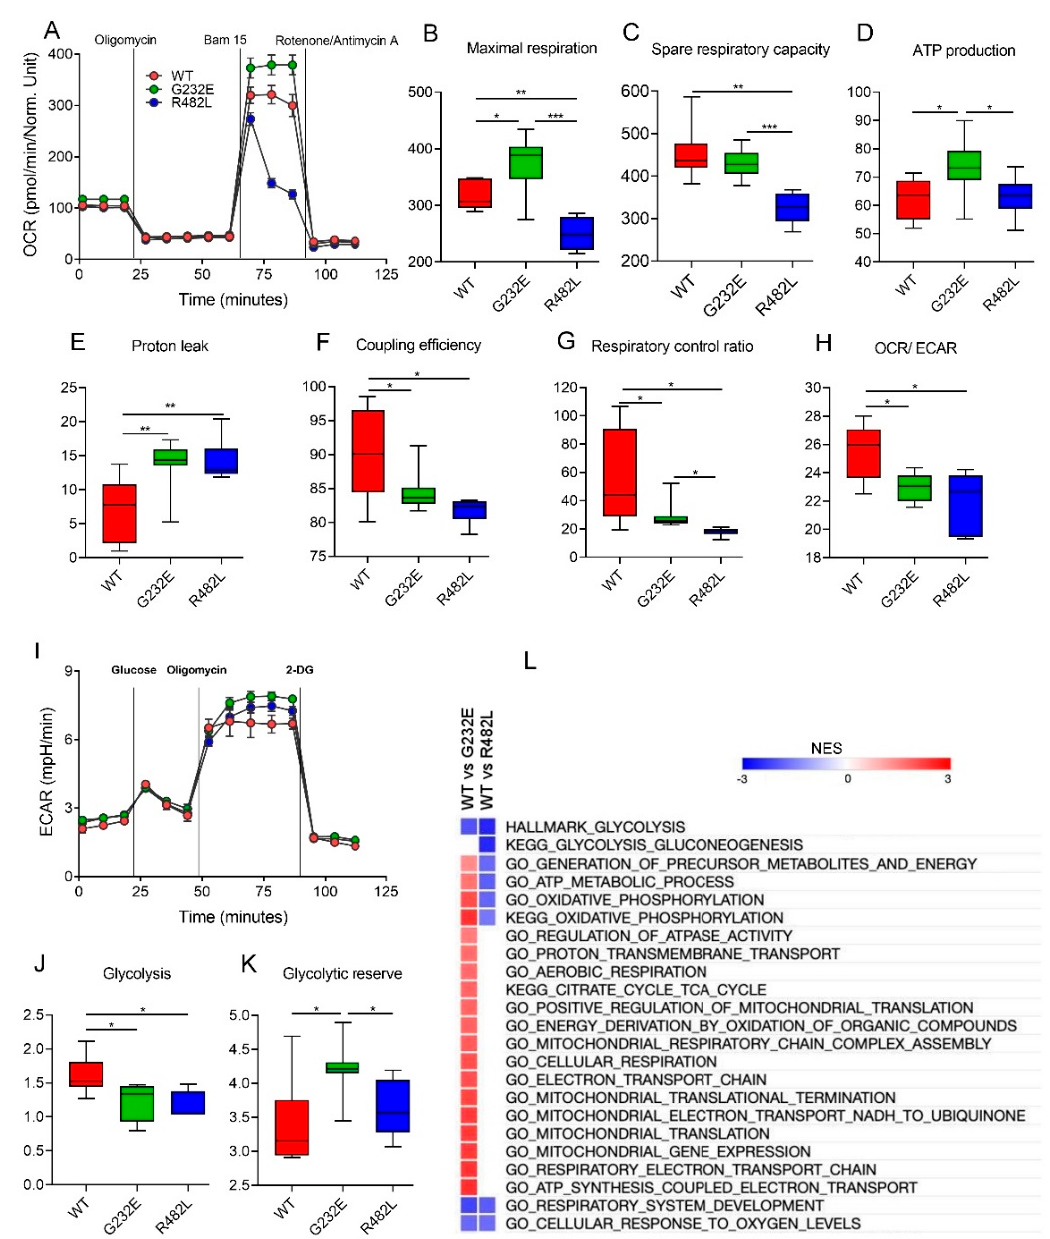
Figure 4. Metabolic profiles of C2C12 myotubes bearing lentiviral WT / G232E / R482L- LMNA . ( A – H ): Determination of mitochondrial bioenergetic parameters from OCR profile. ( A ) OCR traces for myotubes expressing WT / G232E / R482L- LMNA ; ( B – G ) Indices of mitochondrial respiratory function: ( B ) maximal respiratory capacity; ( C ) spare respiratory capacity; ( D ) ATP-linked respiration; ( E ) proton leak respiration; ( F ) coupling e ffi ciency; ( G ) cell respiratory control ratio; ( H ) OCR / ECAR ratio at maximal respiration. OCR was measured at the same time as ECAR. ( I – L ): Determination of glycolytic function. ( I ) Kinetic profiles of ECAR in myotubes expressing WT / G232E- LMNA / R482L- LMNA . ECAR was measured in real time, as indicated. Indices of glycolytic pathway activation calculated from ECAR profile: ( J ) Maximal glycolysis and ( K ) glycolytic reserve capacity. All data are calculated from 6–8 Seahorse microplate wells and are normalized to total protein in each well. * p < 0.05; ** p < 0.01; *** p < 0.001; two-tailed Student’s t -test. All floating bars are shown with mean, minimum and maximum values. ( L ) Heat map of NES values after GSEA analysis represents metabolic pathways found up- or down-regulated in G232E / R482L myotubes compare with WT- LMNA ; FDR = 0.05.